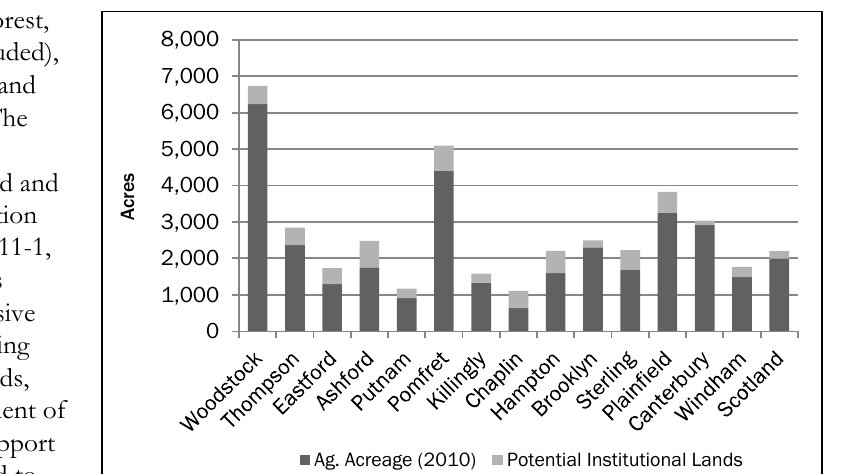
Figure 3. Potential Increases in Agricultural Acreages by Town in Windham County, Based on Institutionally Owned Parcels after Site Suitability Analysis